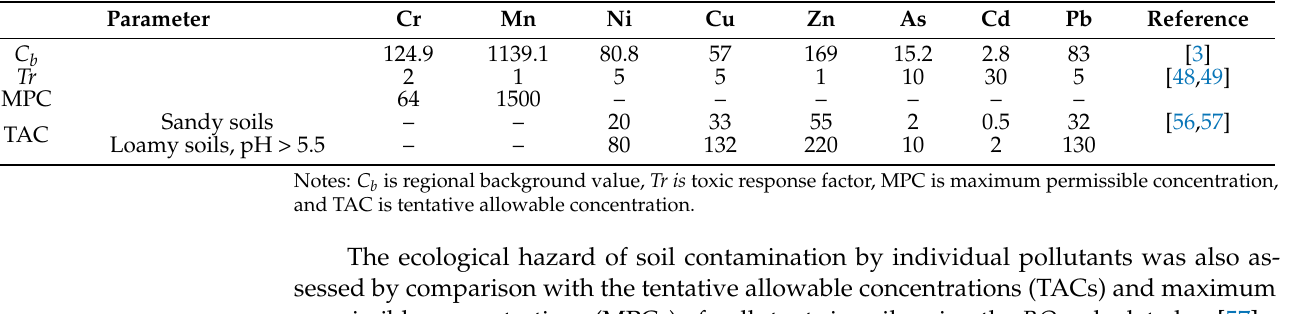
Table 2. Parameters used to assess the ecological risk of